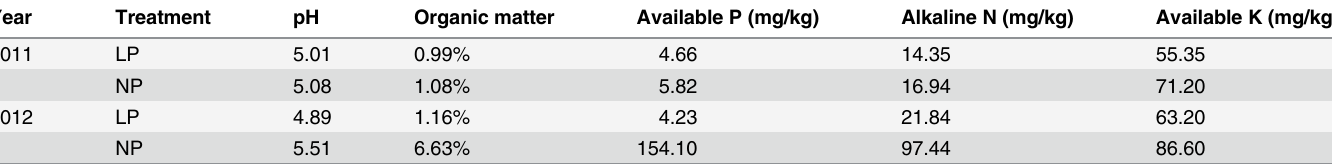
Table 1. Basic chemical characteristics of the soil (0 to 20 cm depth) used to evaluate 826 maize accessions in Guangzhou, China. Available P (mg/kg) Alkaline N (mg/kg) Available K